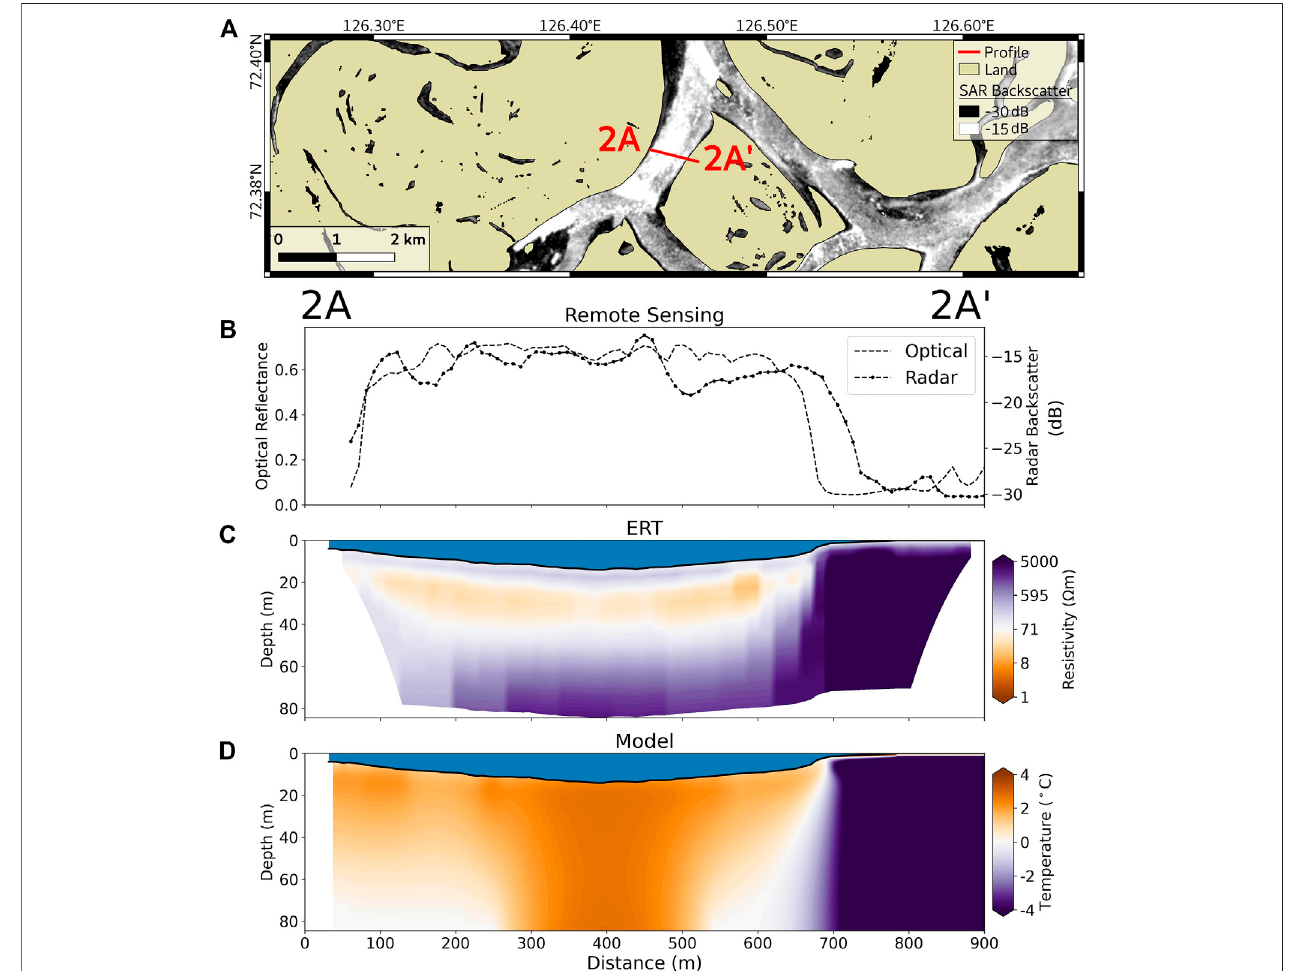
FIGURE5| Pro fi le (2A – 2A ’ ) (forthelocationsee Figure1 ). (A) GPStrackoftheERTpro fi leontopoftheSARSentinel-1medianwinterimageshowingthebedfast (dark) and serpentine (bright) ice. Note that bedfast ice is not present (or has minimal presence) on the pro fi le (2A – 2A ’ ) . (B) Extracted optical re fl ectance and SAR backscatter along the pro fi le. (C) Cross section of the inverted ERT resistivity along the pro fi le. (D) Modeled sediment temperature along the pro fi le.